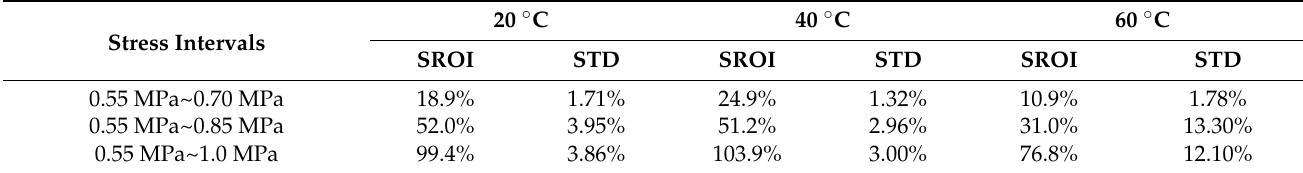
Figure 6. Effect of stress on time–strain creep curves at the same temperature level: ( a ) 20 °C; ( b ) 40 °C; ( c ) 60 °C. Table 2. The strain rate of increases at different stress intervals (for 0.55 MPa).